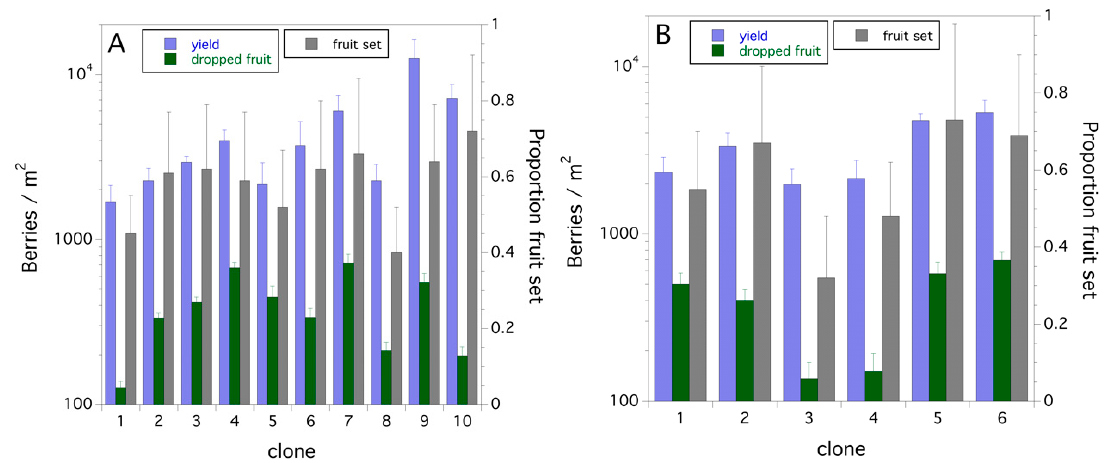
Figure 3. Proportion fruit set, yield (harvested berries / m 2 ) and dropped fruit (green + mature ripe fruit / m 2 ) for individual wild blueberry clones in eastern Maine, USA: ( A ) 2008; and ( B ) 2011.